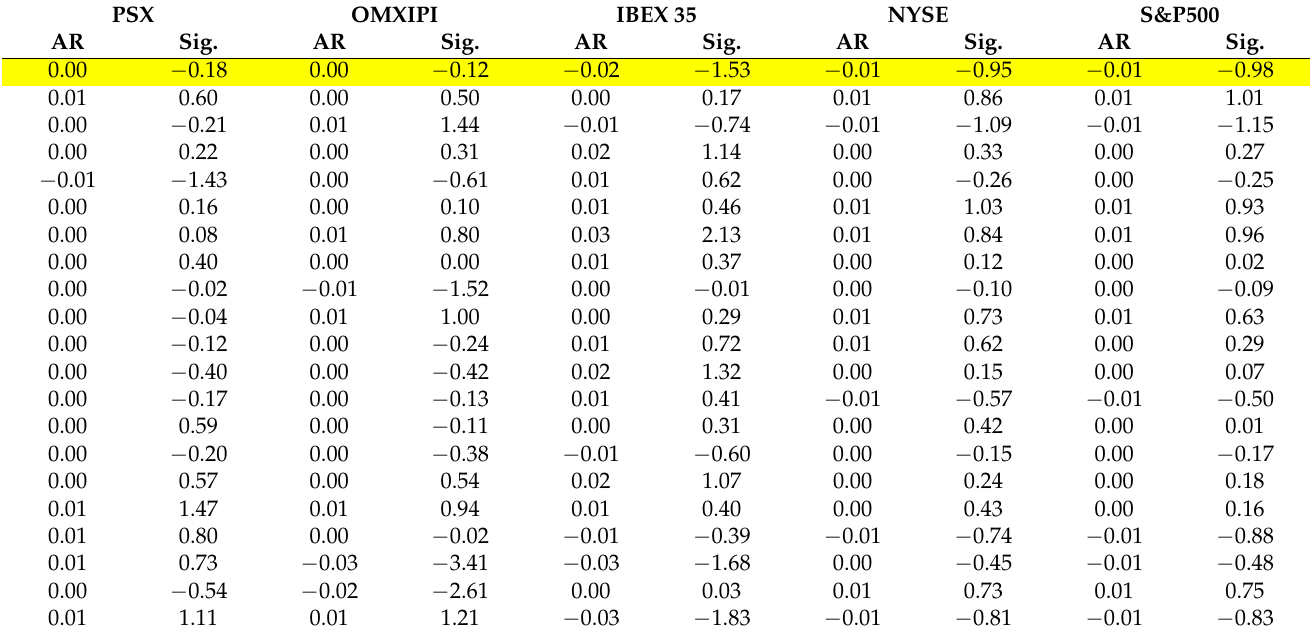
Table A12. Abnormal returns of the (0, +20) event window (Prime Minister of Iceland announced his